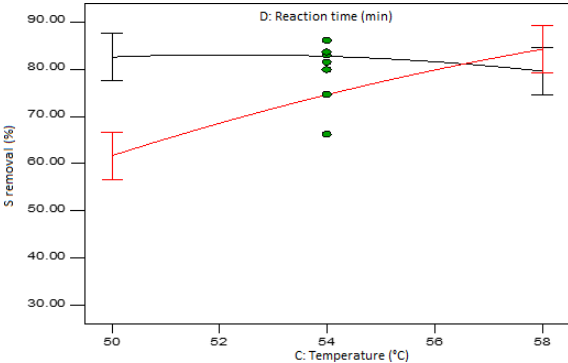
Figure 10: Interaction plot of temperature and reaction time at mid- level formic acid and hydrogen peroxide